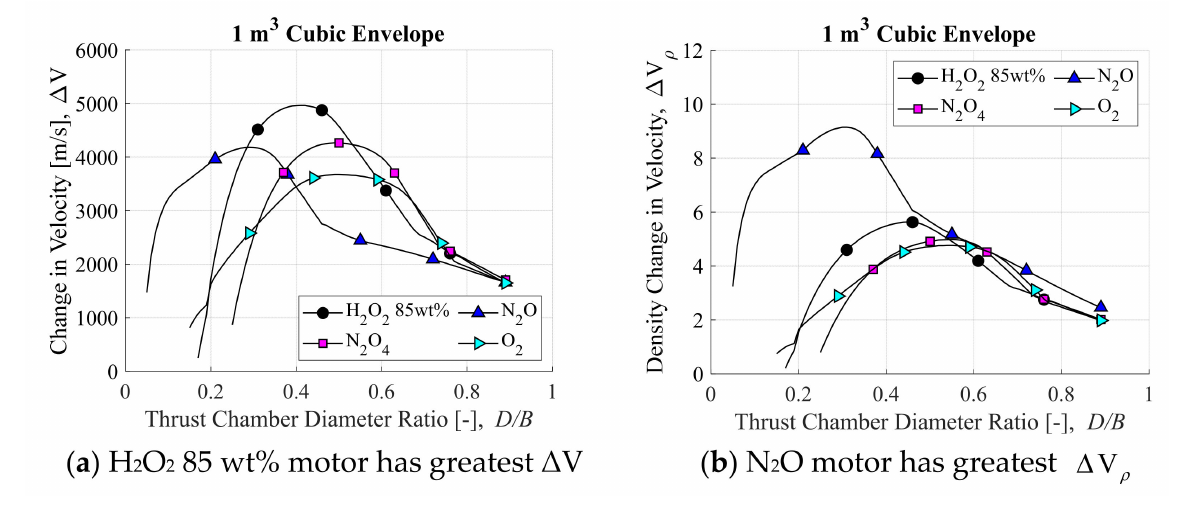
Figure 12. Comparing the ideal ∆ V and ∆ V ρ of each